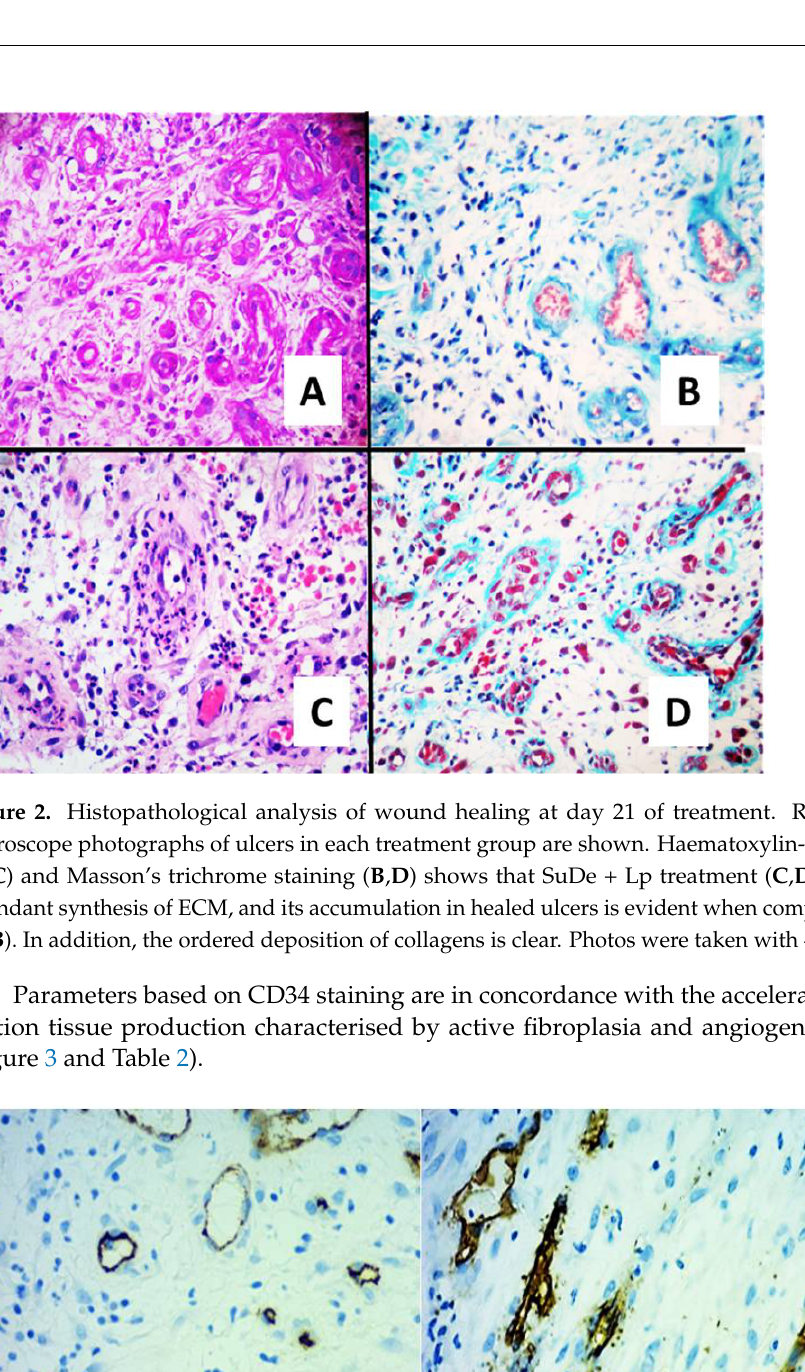
Table 2. Immunohistochemical staining of samples with anti-CD34.VA: vascular area, NV: number of vessels, EC: CD34 + endothelial cells. * p < 0.05 when comparing CD34 + cells in SuDe + Lp vs. SuDe groups.